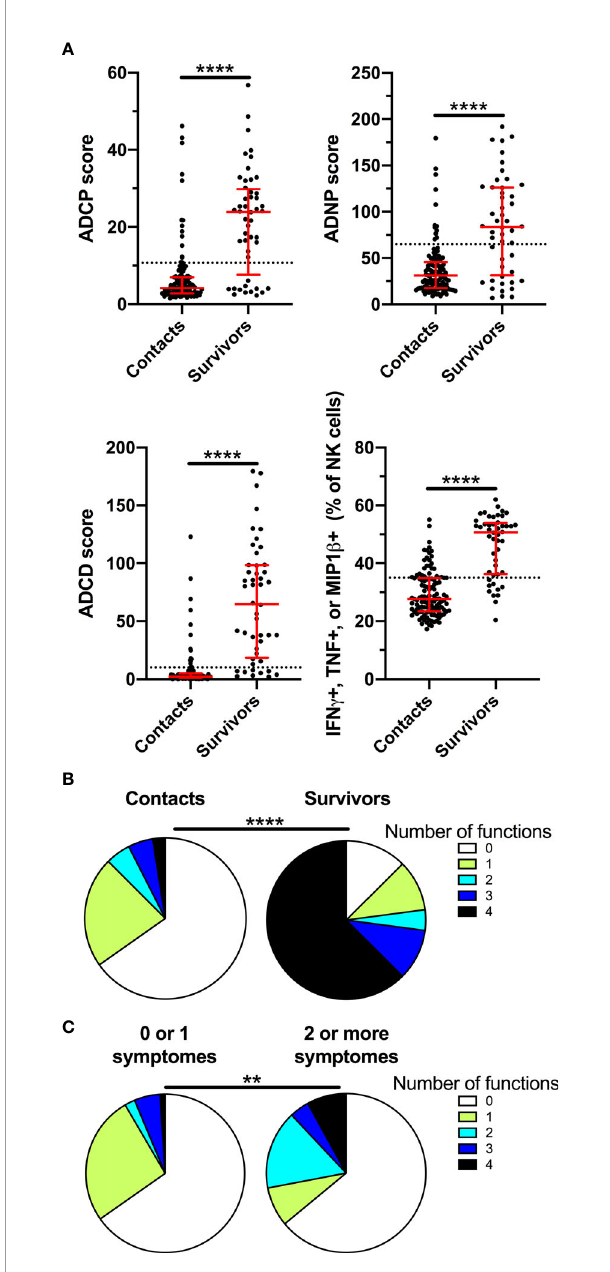
FIGURE 1 | BDBV survivors maintain polyfunctional antibody effector functions for two years. ADCP, ADNP, ADCD, and ADNKA were measured in plasma of BDBV survivors (n=48) and household contacts (n=121) (A) . The line and whiskers represent the median and interquartile range respectively. The dotted line represents the cutofffor positivity. Pie chart indicating the number of positive functions for BDBV survivors and household contacts (B) . Pie chart indicating the number of positive functions for household contacts with one or less (n=95) and two or more symptoms (n=25) at the time of the outbreak (C) . **** represents p values < 0.0001 and ** represents p values <